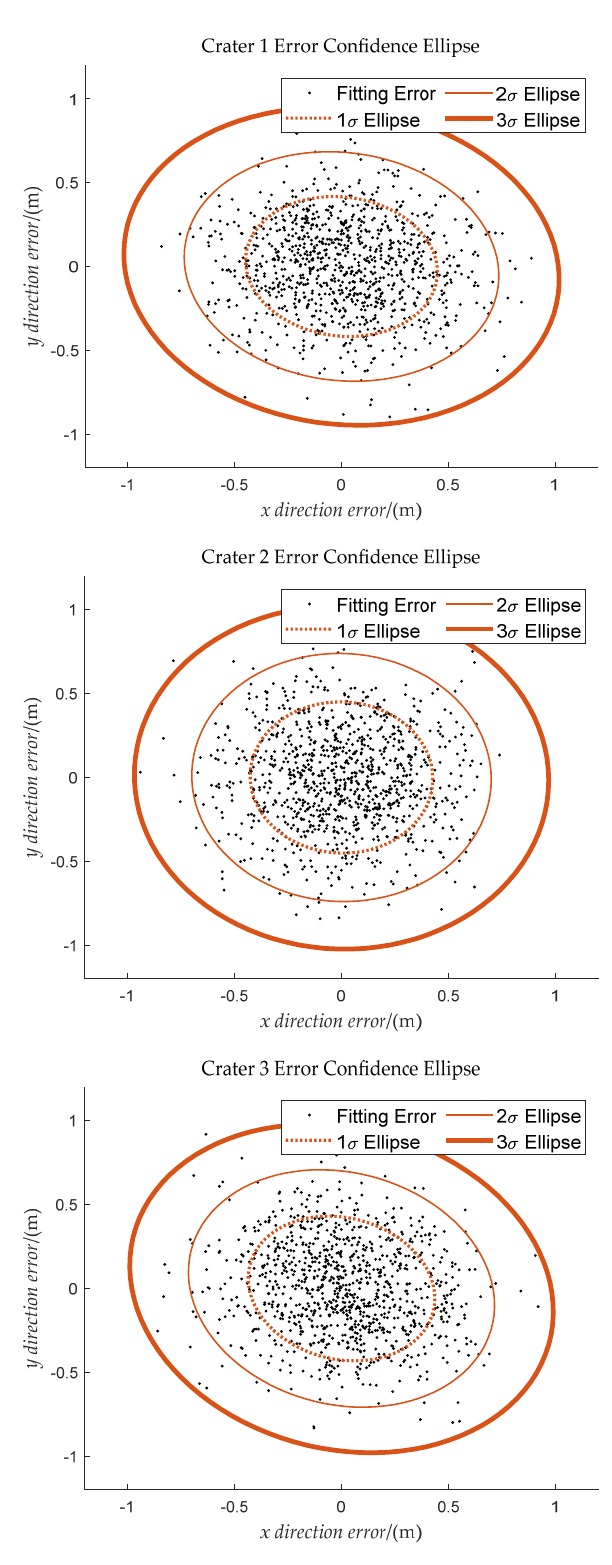
Figure 9. Crater fitting and Monte Carlo confidence ellipses.